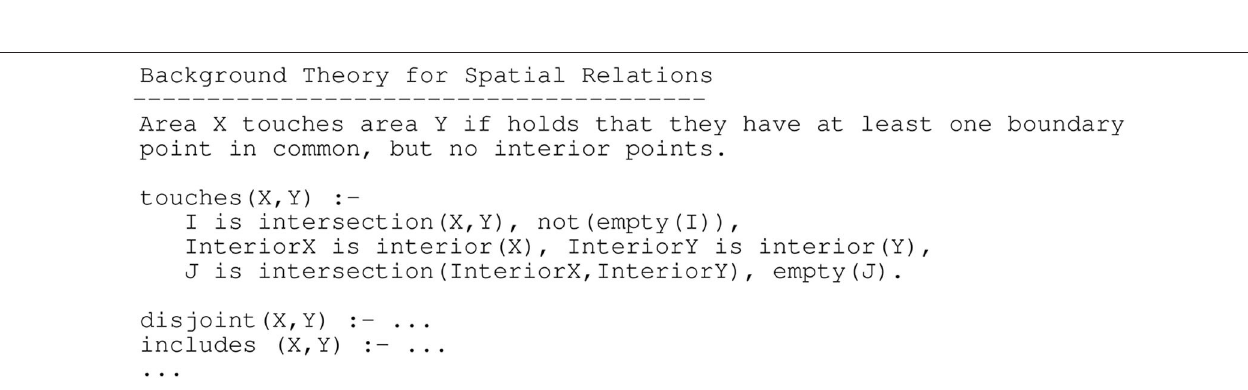
FIGURE 8 | Background theory with domain rules for a hypothetical diagnostic domain of colon cancer (Schmid and Finzel,